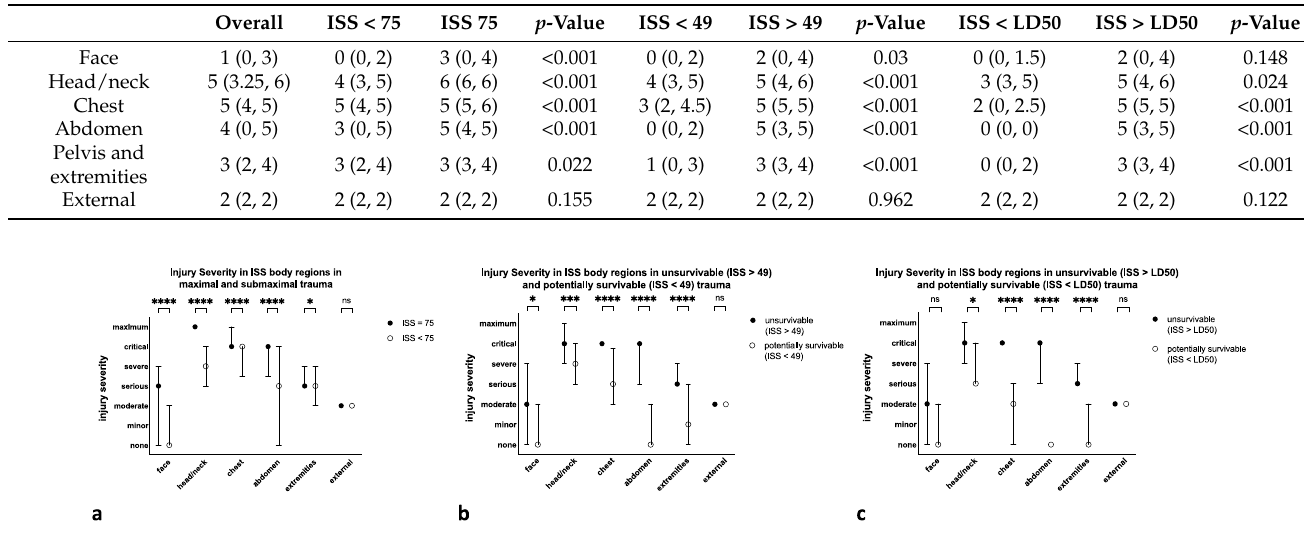
Figure 6. Median and IQR of injury severities according to the AIS-98 within the respective ISS body regions for prehospital